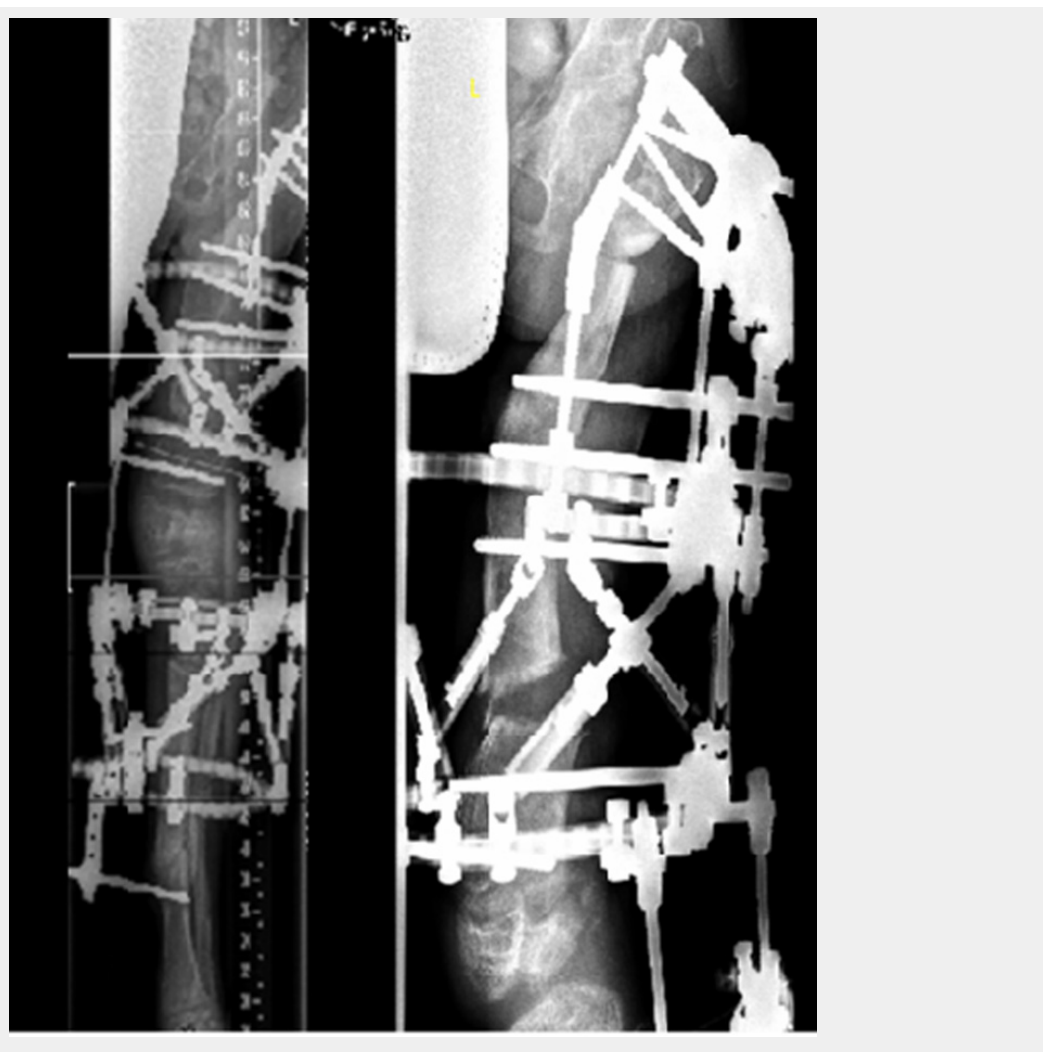
Figure 4 Three months later, the deformity of the left side was fully corrected by gradual